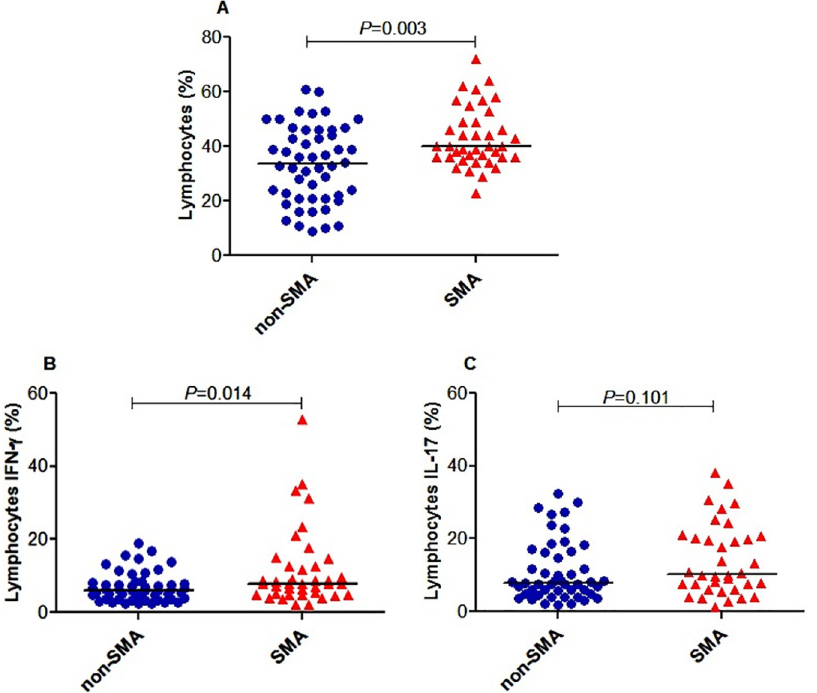
Fig 2. Lymphocytes expressing IFN- γ and IL-17 in acute malaria. Data are presentedas proportions (%). The proportions were determined by flow cytometry immediately after staining.The proportions of different lymphocyte populationswere determined using FlowJo Software (TreeStar, Ashland, OR, USA). The line in the middlerepresentsthe median value. Betweengroups comparisons were performed by Mann-Whitney U test. (A) The proportionof lymphocyteswas higherin the SMA group relative to non-SMA group. (B) The proportionof lymphocytes expressing IFN- γ was higherin the SMA group relative to non-SMA group. (C) The proportionof lymphocytes expressing IL-17 was higher in the SMA group relative to non-SMA group.